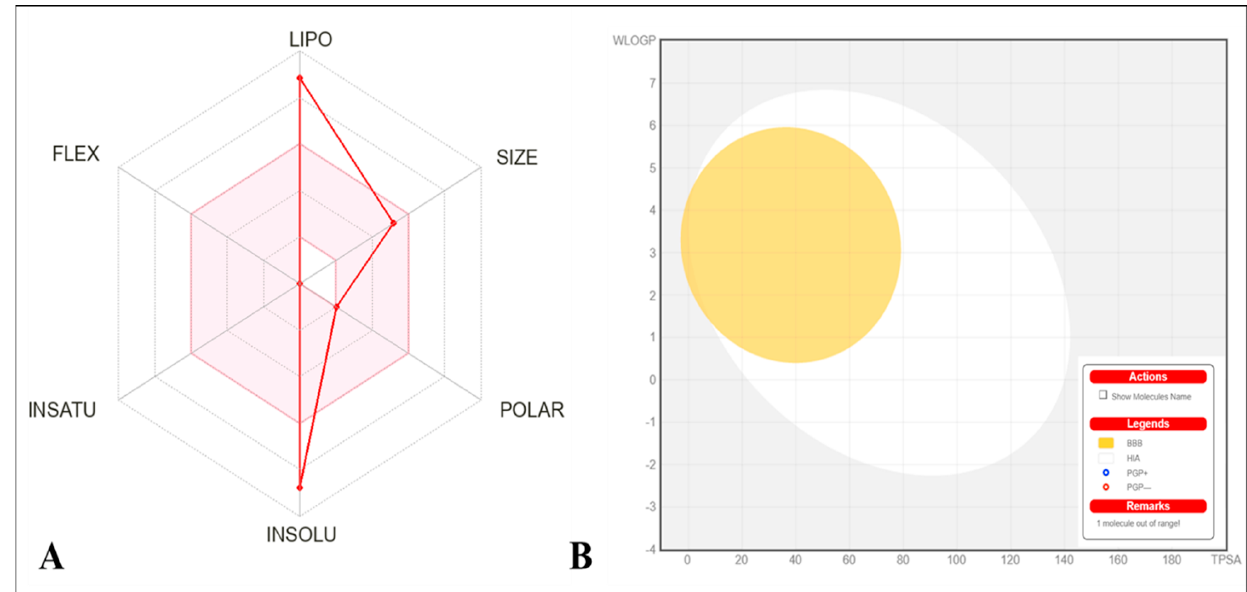
Figure 7. ( A ) Radar chart representing bioavailability pattern of EFD. The pink zone indicates the oral bioavailability physicochemical space, while the red line reflects the oral bioavailability parameters. ( B ) BOILED-Egg plot predicted for EFD using the Swiss ADME online web tool.